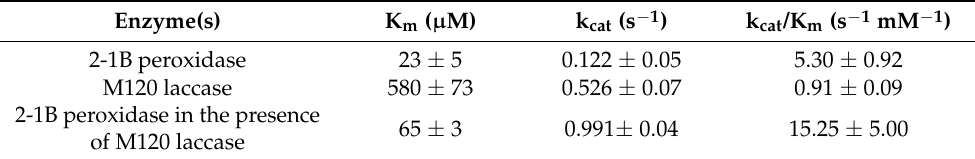
Table 1. Kinetic/catalytic characterization of 2-1B peroxidase, M120 laccase, and their